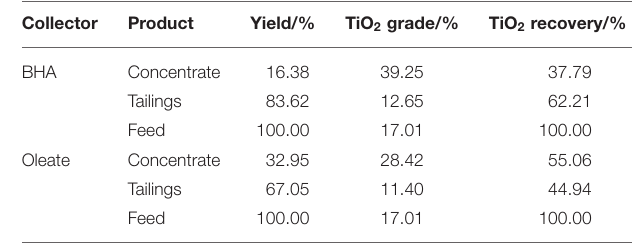
TABLE 1 | Flotation results of BHA and oleate.